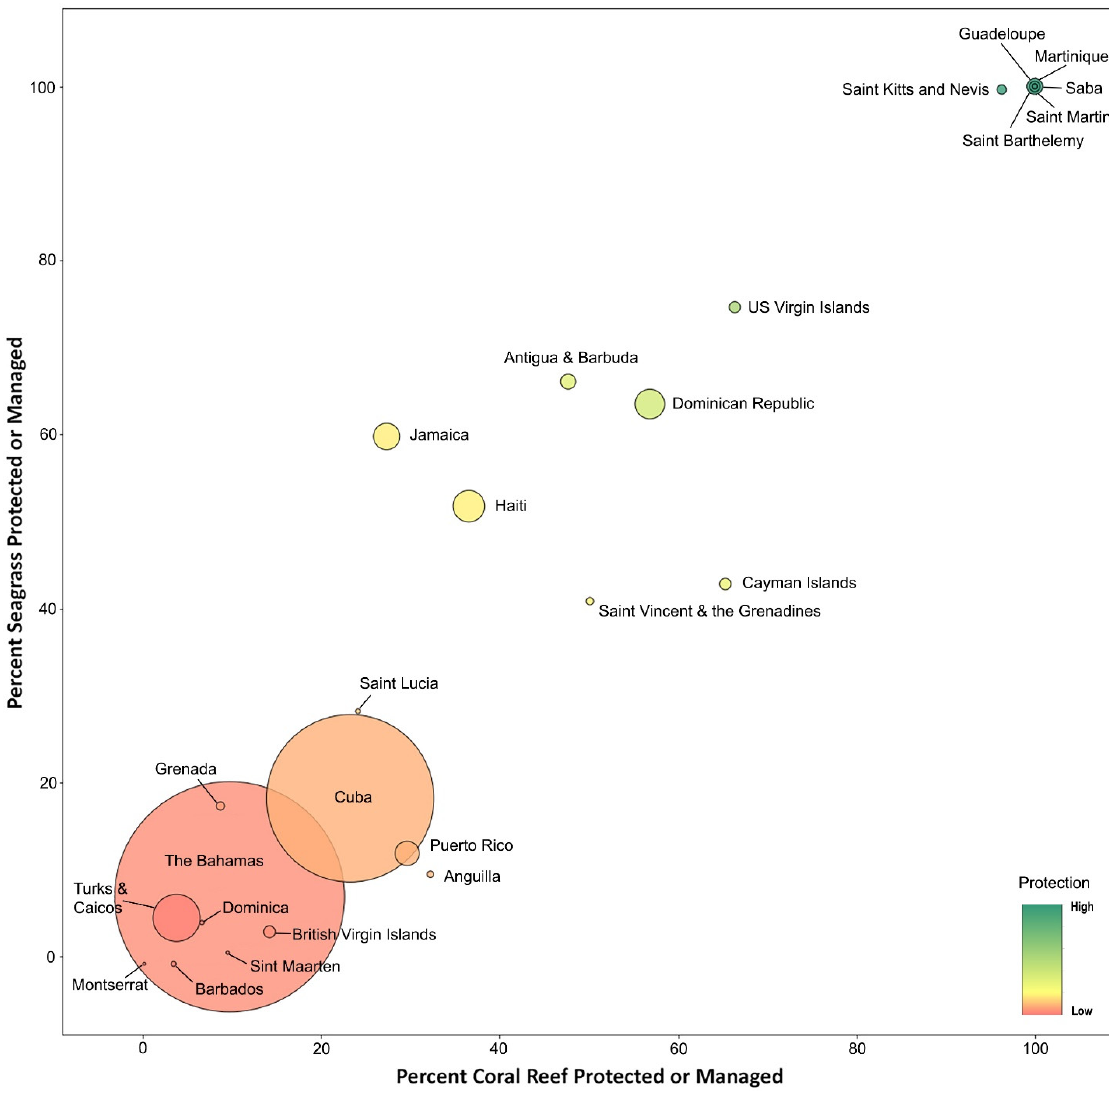
Figure 13. Percentage of seagrass protected against the percentage of coral reef protected per jurisdiction, based on The Nature Conservancy’s Caribbean’s declared marine protected or managed area database. The size of the circle is relative to the total area of seagrass and coral reef habitat within each jurisdiction (i.e., Exclusive Economic Zone (EEZ)). The French jurisdictions of Guadeloupe, Martinique, Saint Martin, and Saint Barthelemy all maintain 100% protection because the entire EEZ is declared as a marine mammal